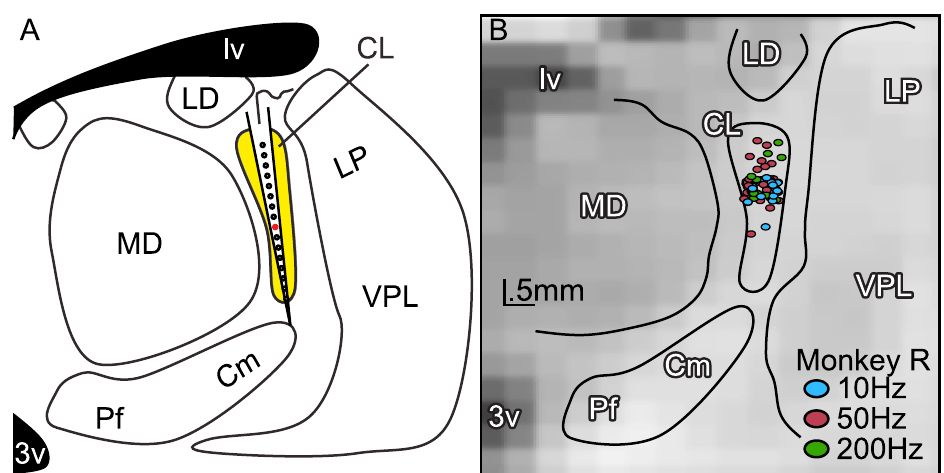
Fig 1. Structural imaging used to target multi-microelectrode DBS to the central lateral thalamus. A: Schematic of coronal thalamic section (right hemisphere) with tailored DBS electrode placed such that contacts span the dorsal- ventral extent of CL (yellow). We simultaneously stimulated via 16 electrode contacts (200 μ m spacing between contacts), with the centermost contact (contact 8) shown in red. B: Track reconstruction of DBS sites overlain on the high-resolution structural image of the thalamus (monkey R, right hemisphere, A8). Only the centermost contact location shown (colored circles) for clarity. For each stimulation, 8 contacts above and 7 contacts below the colored circle would also be stimulated. To improve visualization by reducing overlap, positions plotted with up to 1 voxel (.5mm) jitter separately for 10, 50, and 200Hz experiments. Black lines demarcate different thalamic nuclei: central lateral, CL; centromedian, Cm; lateral dorsal, LD; lateral posterior, LP; mediodorsal, MD; parafascicular, Pf; ventral posterior lateral, VPL. Stimulation performed at all frequencies for most sites.